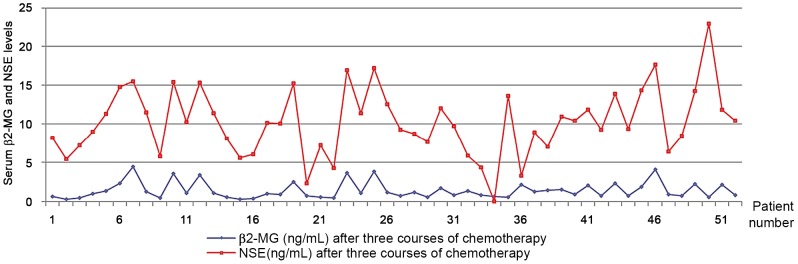
Correlation between NSE level and the amount of prognostic indicator β2-MG in MM patients after receiving three courses of chemotherapy.